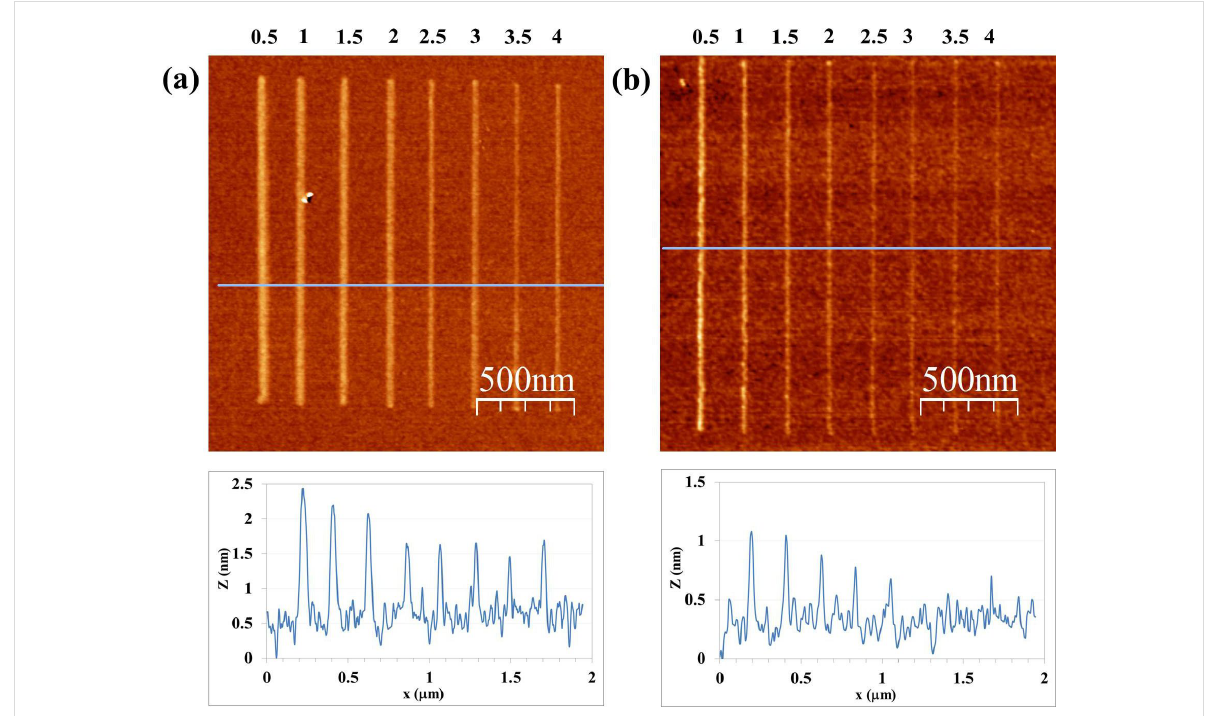
Figure 2: Results of LAO-AFM on Si with CNF (a) and Si (b) probes as a function of the writing speed ( μ m/s). Bias voltage is 20 V, relative humidity (RH) is 36%.